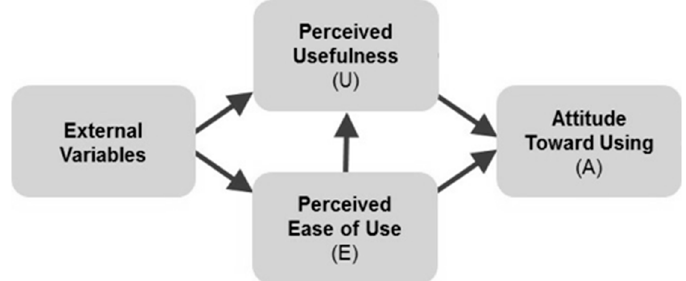
Figure 1. Research model